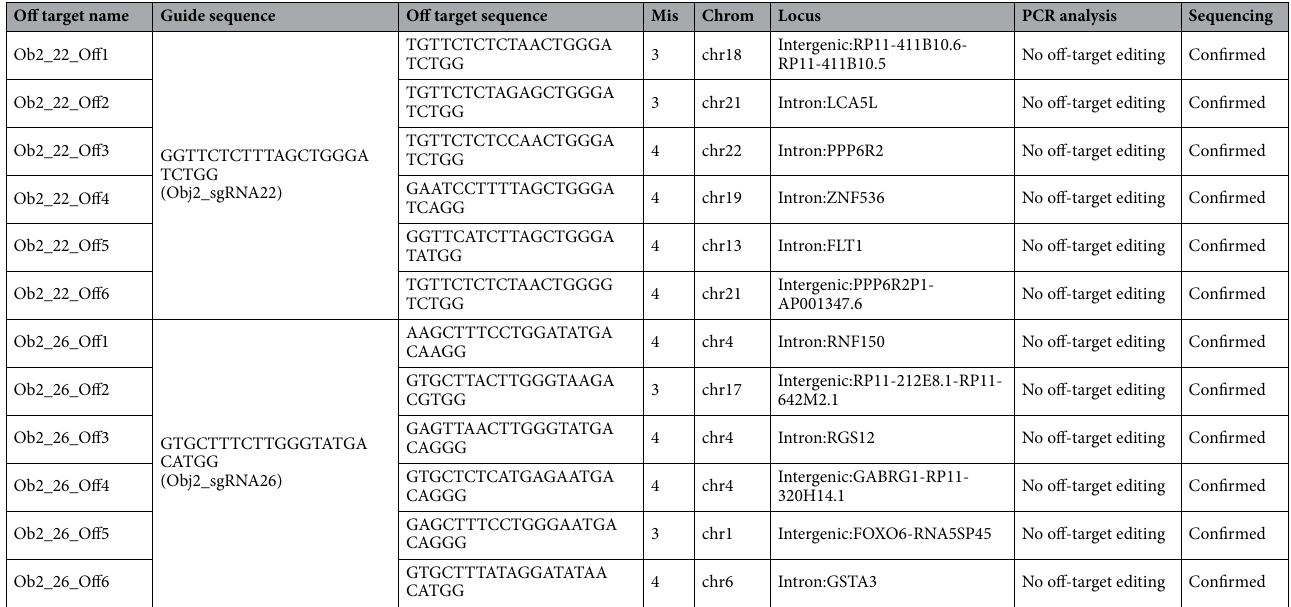
Table 3. Objective 2 potential off-target sites analyses. Top 6 off-target sequences of Obj2_sgRNA22 and Obj2_sgRNA26 identified with CRISPOR webtool, including the mismatches between sgRNAs, the off-target sequence, the chromosomes and loci targeted. All of them were analysed by PCR and Sanger sequencing, and no off-targets were